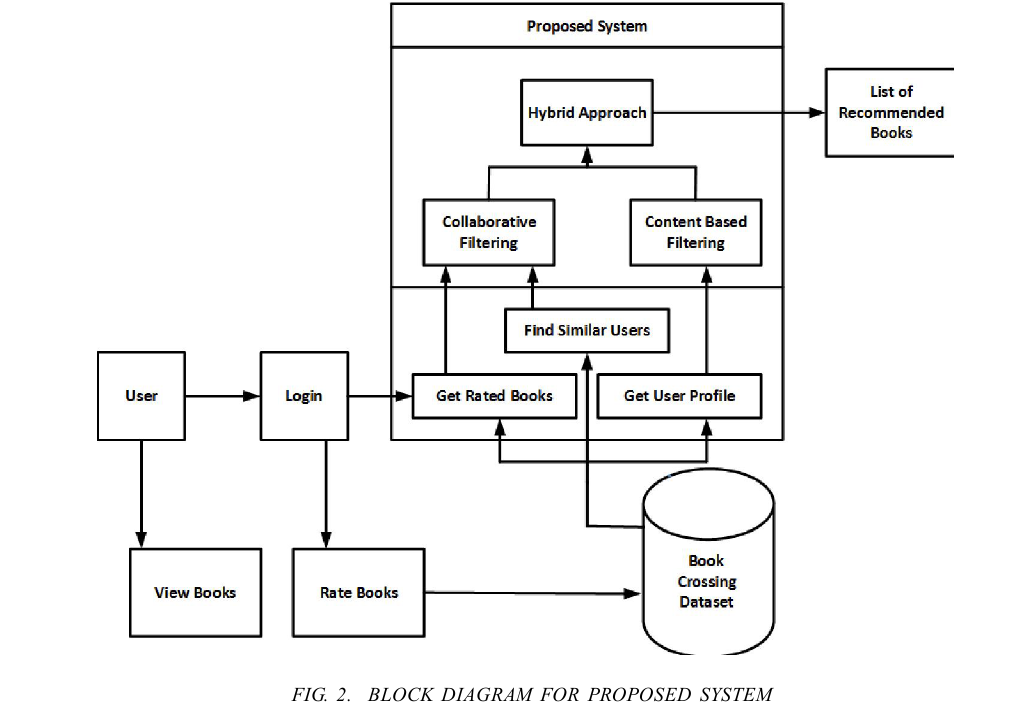
FIG. 2. BLOCK DIAGRAM FOR PROPOSED